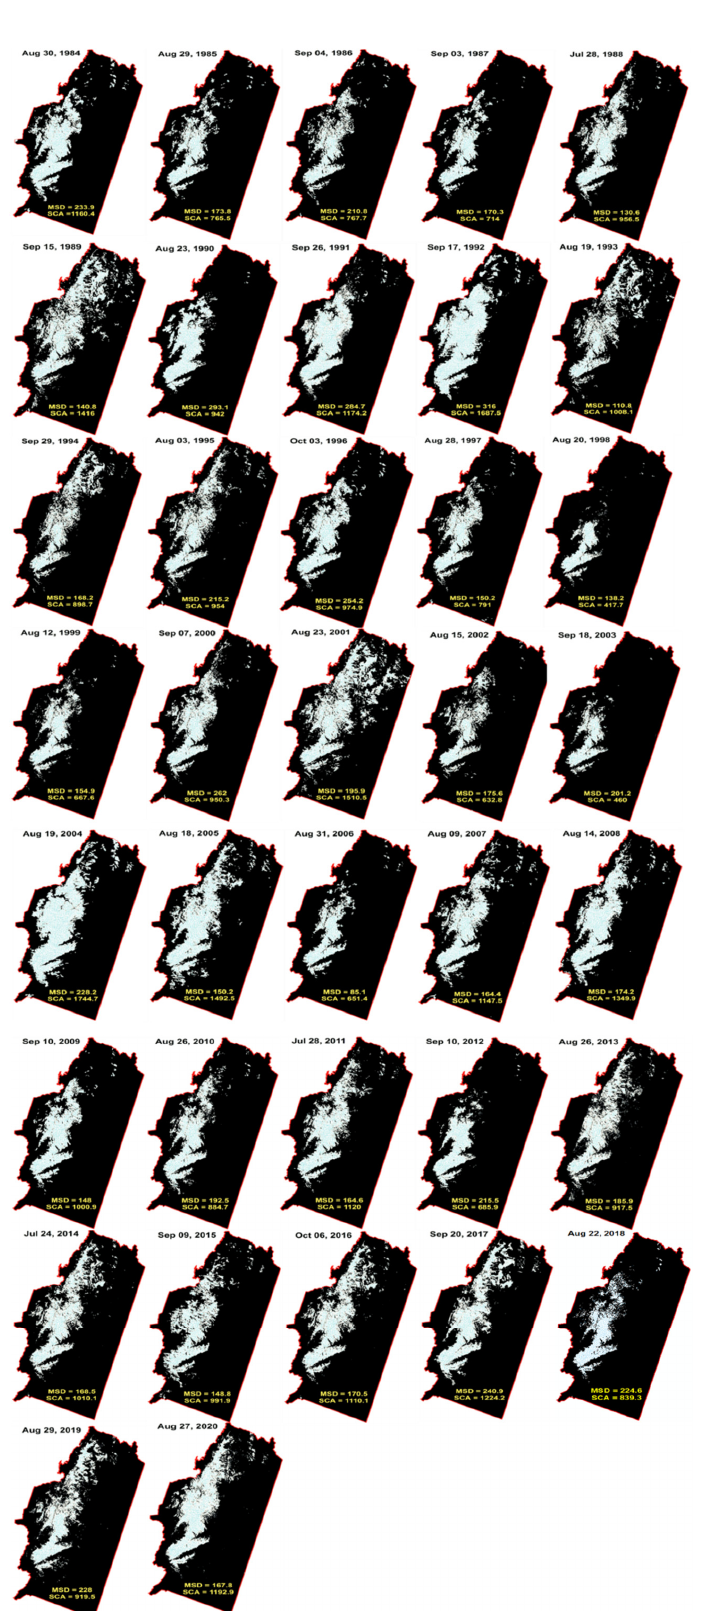
Figure 6. The temporal–spatial variations of the annual maximum SCA inside the Snowy Mountains area from 1984 to 2020. The MSD and SCA for each year are shown in each panel. The minimum, average, and maximum SCAs are 417.7, 1003.6, and 1774.7 km 2 . The standard deviation is 308.3 km 2